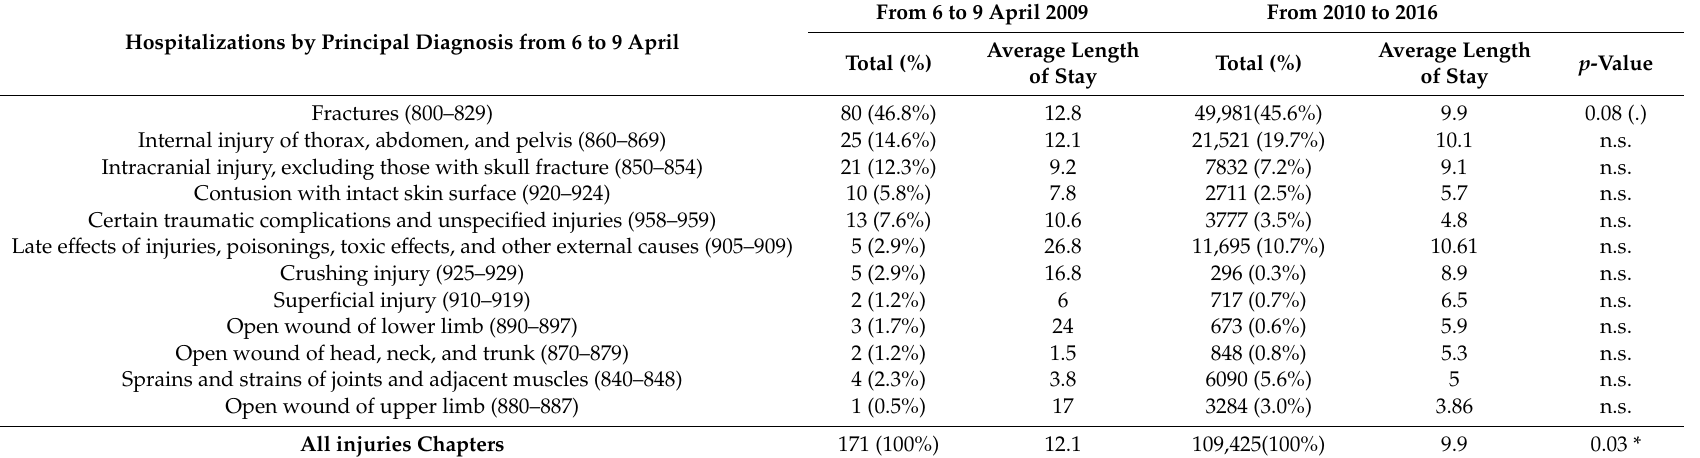
Table 4. Frequencies and average length of stay among the population in the seismic crater in 6–9 April 2009 and in the overall Abruzzo region admitted to hospital due to injuries in 2010–2016. (ICD-9-CM, Injury